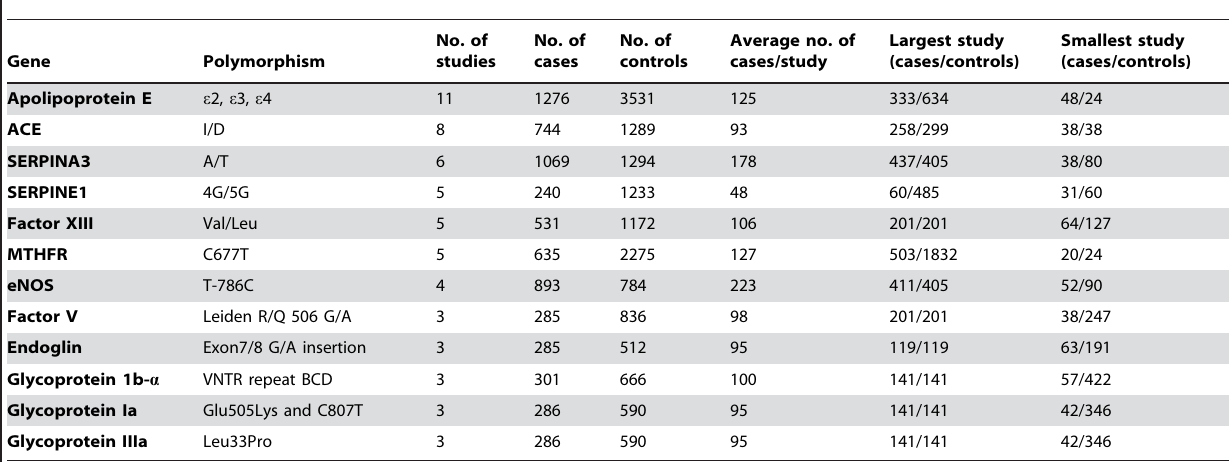
Table 1. Details of size of studies included in each gene